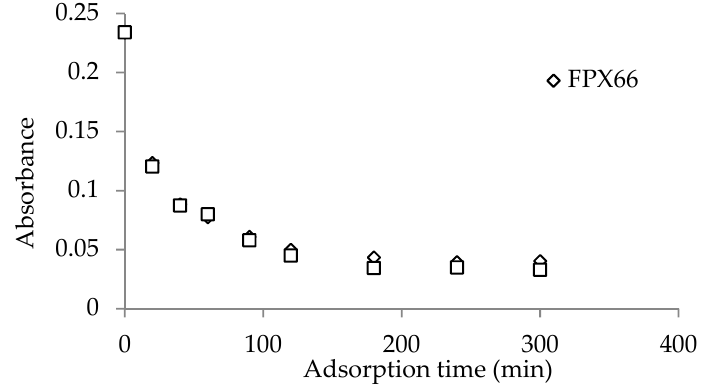
Figure 5. Adsorption kinetics of total flavonoids for EXA-118 and FPX66 resins.